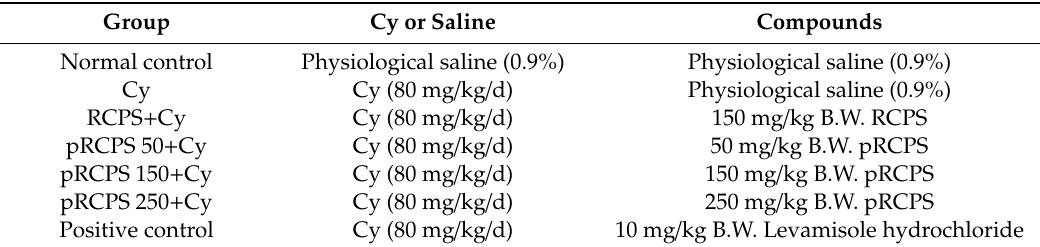
Table 1. Treatment of animal